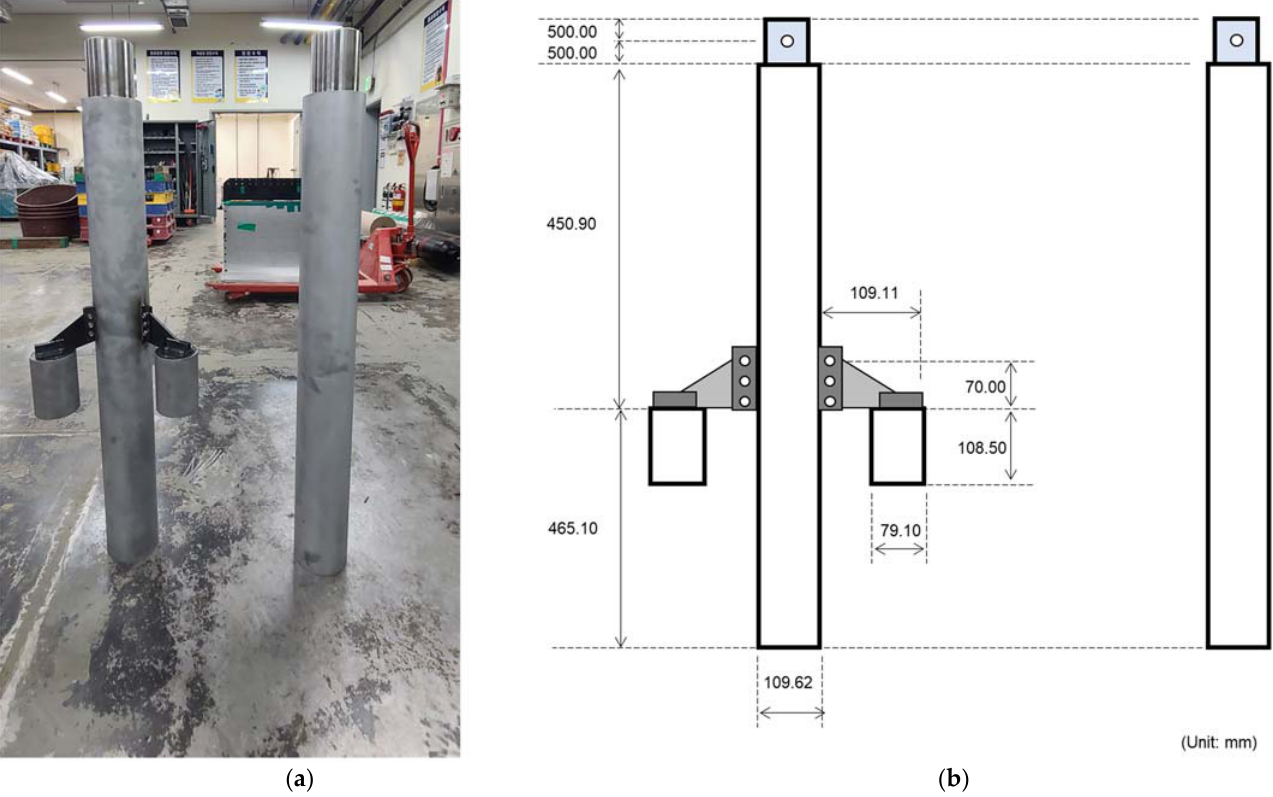
Figure 3. Physical test models of hybrid and conventional monopiles: ( a ) small ‐ scaled test models; ( b ) dimensions of small ‐ scaled tests models. Table 1. Dimensions of the proposed hybrid monopile for physical test model.